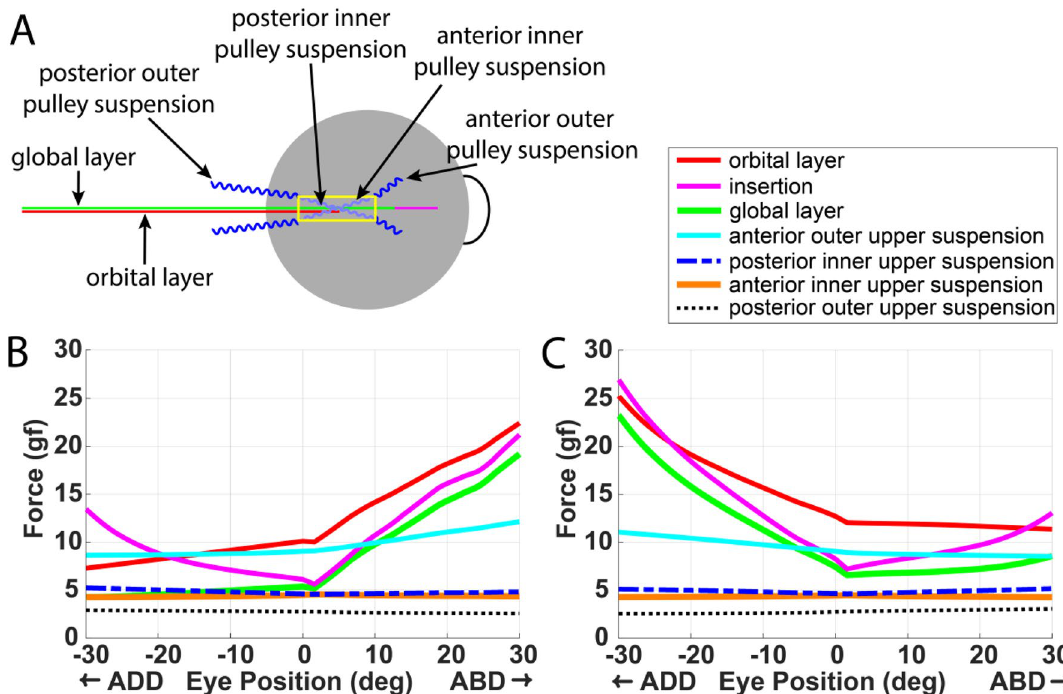
Figure 3. ( A ) Diagram showing EOM layers and suspensions. Simulated tensions of ( B ) lateral and ( C ) medial rectus muscles and their associated pulley suspensions at different horizontal eye positions.